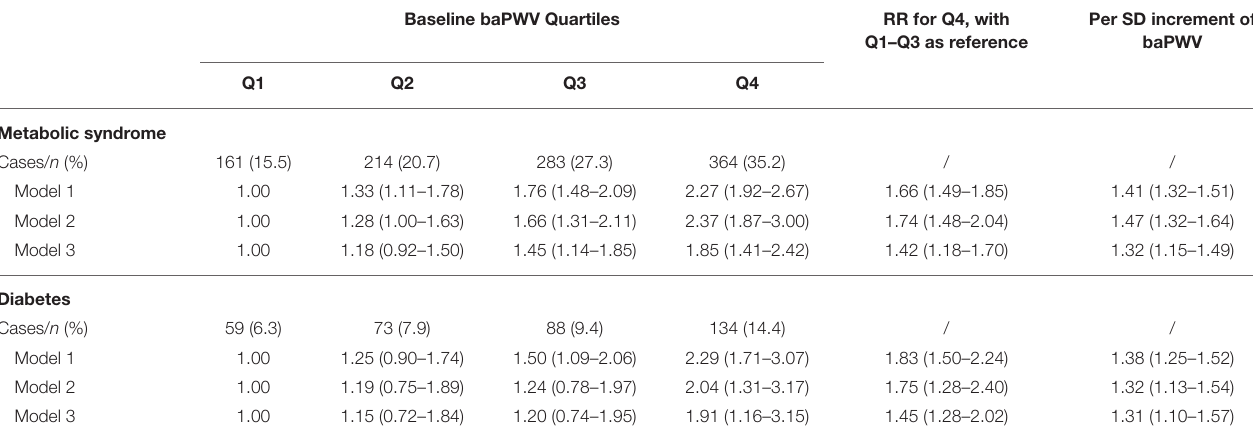
Baseline baPWV Quartiles RR for Q4, with